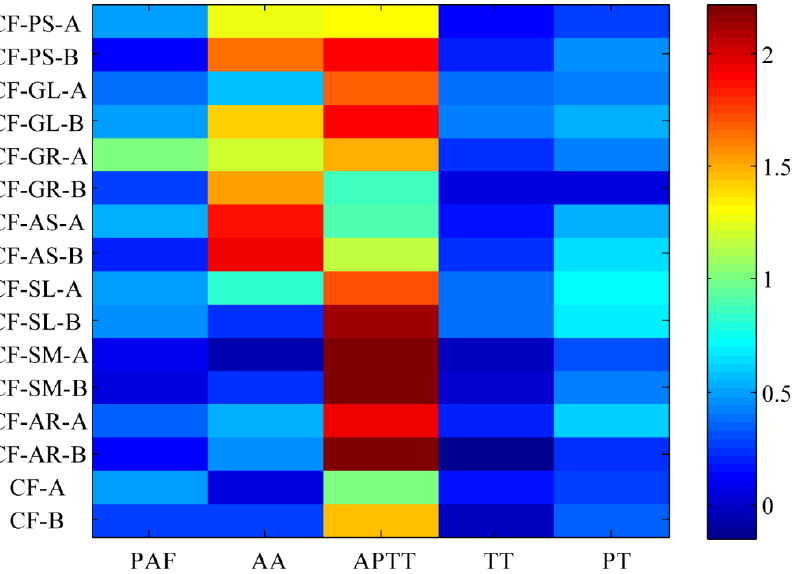
Figure 19. Hot map of contribution to different biological activities in the safflower series of herb pairs.